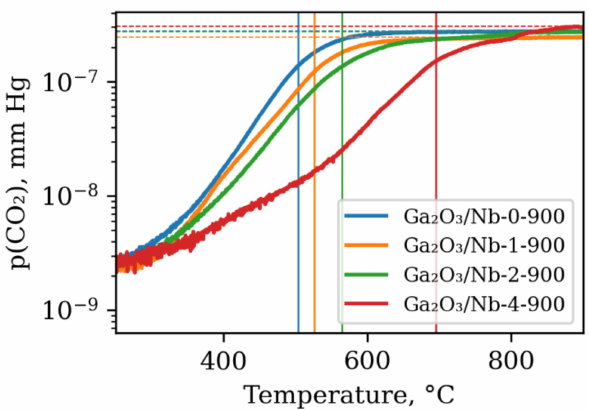
Figure 6. Dependency of partial CO 2 pressure at the reaction chamber outlet on sample temperature during CO oxidation in the presence of oxygen. Vertical lines indicate temperature of CO 2 half conversion and are 503 ◦ C, 526 ◦ C, 564 ◦ C and 695 ◦ C for pure β -Ga 2 O 3 and 1,2,4 mol.% Nb containing materials, respectively.